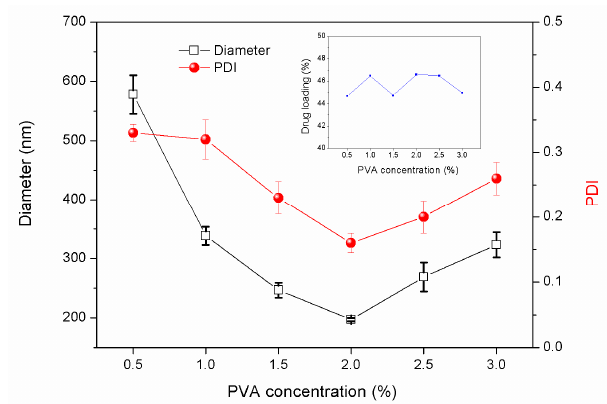
Figure 1. Particle size, size distribution, and LC loading capacities of PLA nanoparticles prepared under different PVA concentrations (water–oil ratio was 4:3, PLA concentration was 133 g/L, and LC-PLA ratio was 1:1).